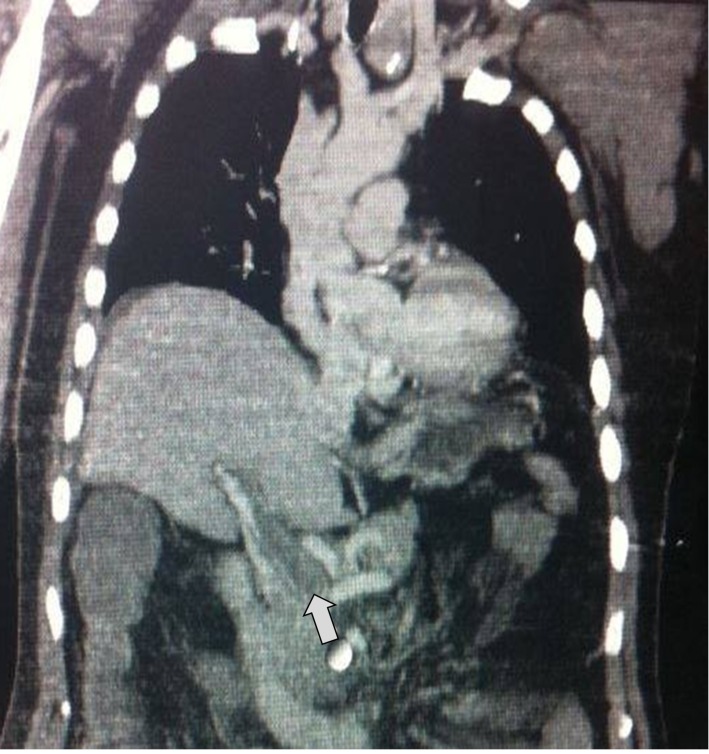
Computed tomography of chest and abdomen, showing thrombosis in the portal vein (arrowed).